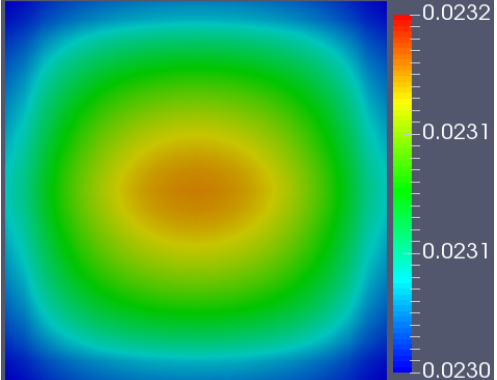
Figure 2. Coke distribution patterns at 24 min.